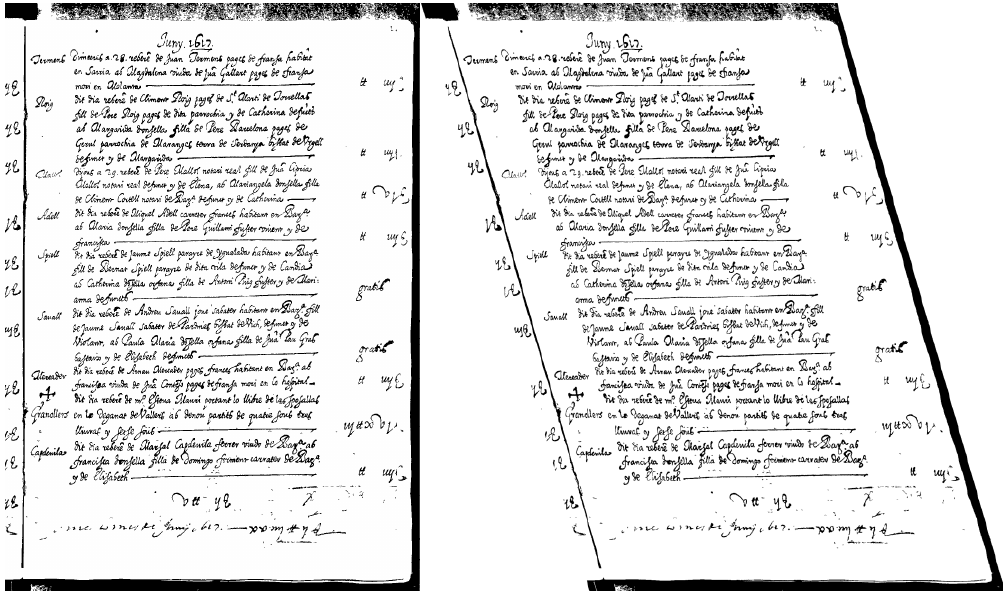
Figure 8. Application of our slant removal technique on sample from BH2M DB ( left ); corrected by −17° ( right ). − 17 ◦ ( right